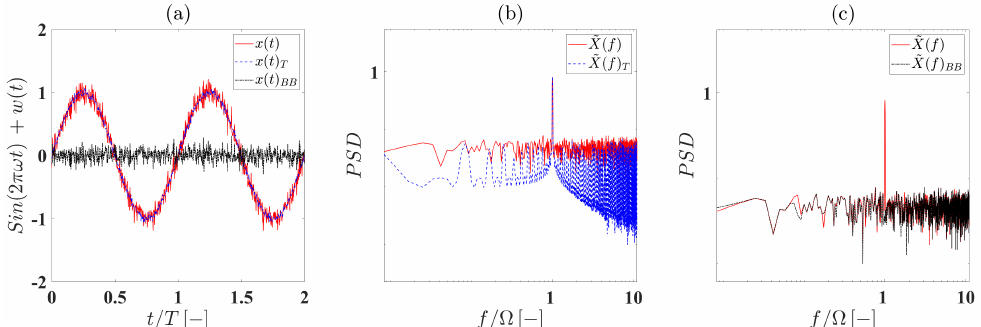
Figure 5. Application of the POD–based decomposition strategy to a synthetic signal: a noisy sine wave. ( a ) Signals, total and reconstructed, in the time domain; ( b ) the total and reconstructed tonal signals in the frequency domain; ( c ) the total and reconstructed broadband signals in the frequency